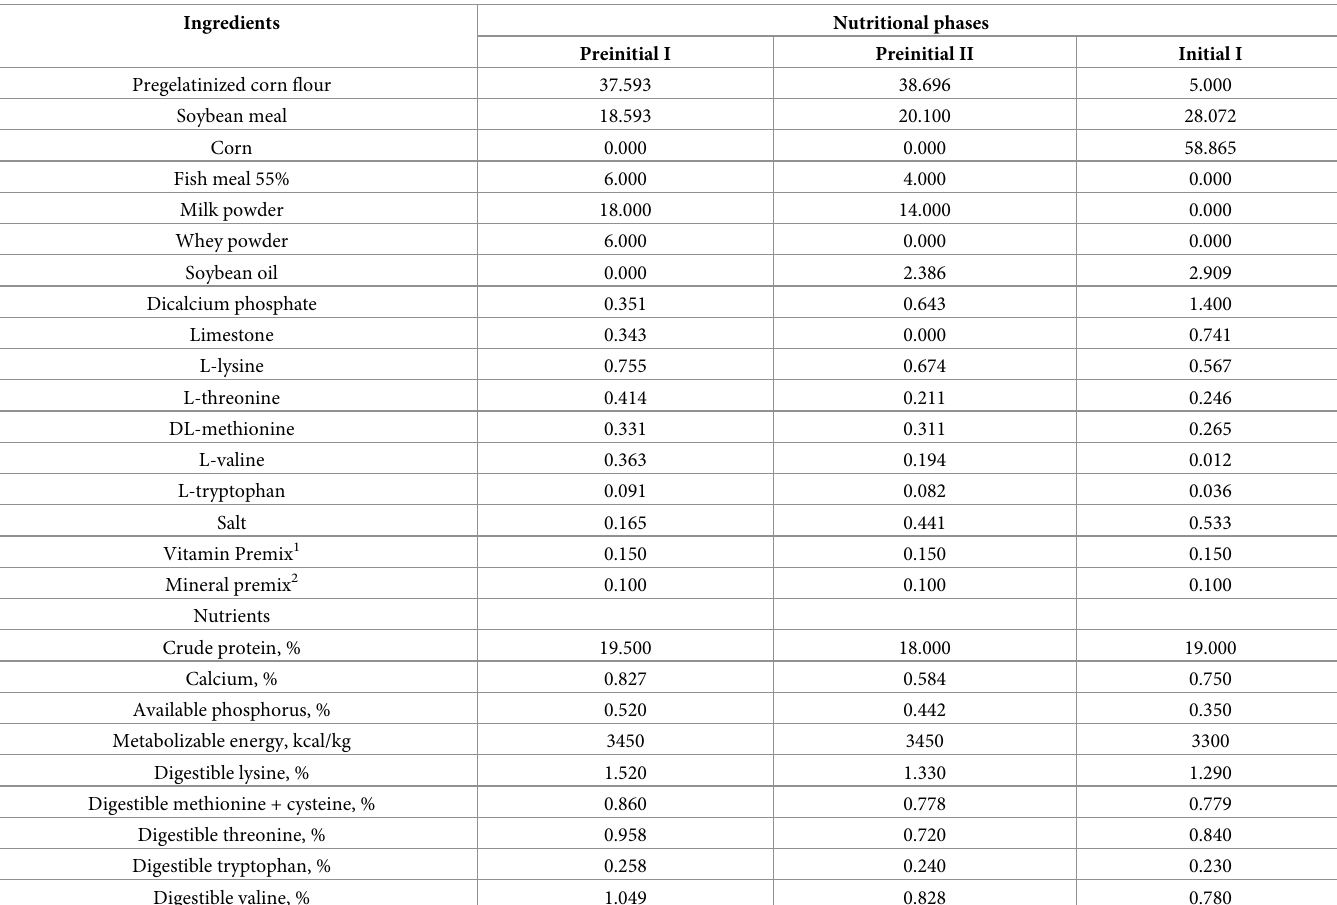
Table 1. Ingredients and calculated composition according to the nutritional